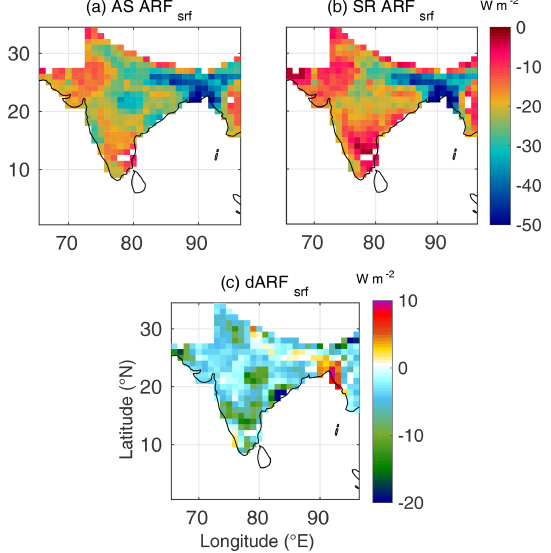
Figure 3. Spatial variation of (a) AS ARF srf (radiative forcing esti- mated using AS AOD and AS SSA, at the surface), (b) SR ARF srf (radiative forcing estimated using SR AOD and SR SSA, at the sur- face) and (c) dARF srf for January 2009.